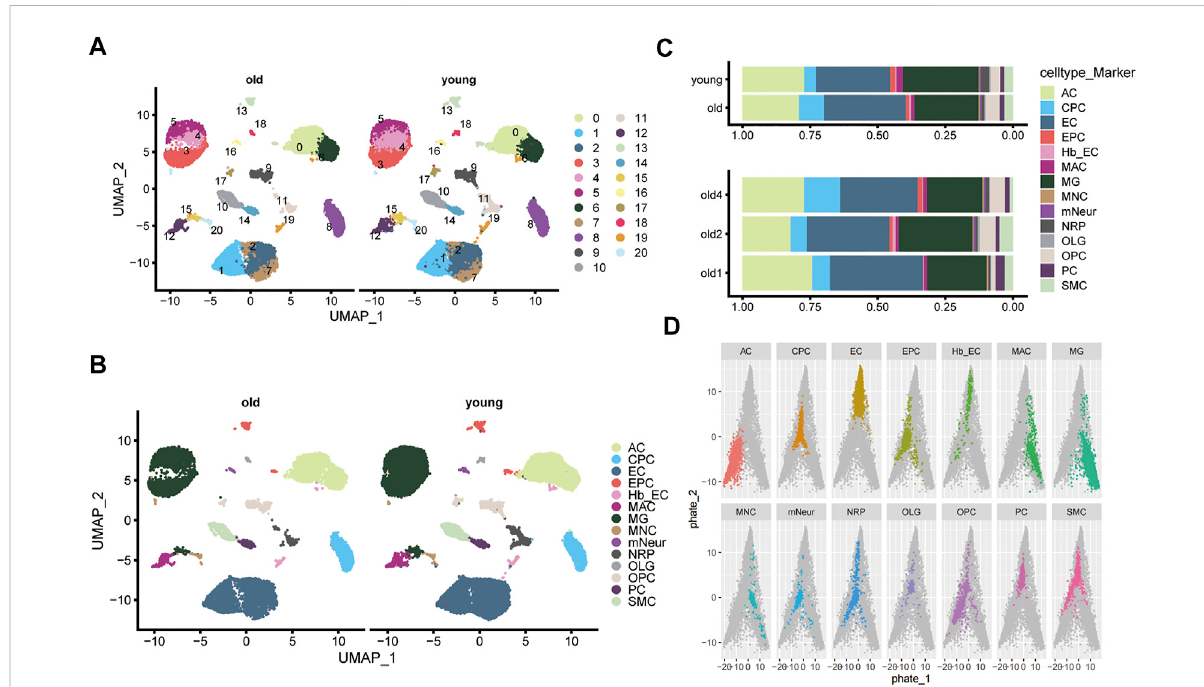
FIGURE 2 Single-cell clustering and sub-clustering of mouse brain tissue. (A) Uniform Manifold Approximation and Projection (UMAP) plot shows the clustering of cells in the old and young groups. Different colors distinguish different subgroups. (B) The UMAP plot shows the 14 cell types identi fi ed in the old and young groups (including: AC, CPC, EC, EPC, hb EC, MAC, MG, MNC, mNeur, NRP, OLG, OPC, PC, and SMC). (C) The bar graphs show the proportion of each cell type in the old and young groups. (D) PHATE maps the distribution of different cell types based on the scRNA-seq pro fi le of GSE147693. The colored dots indicate the speci fi ed cell types, and gray dots represent other